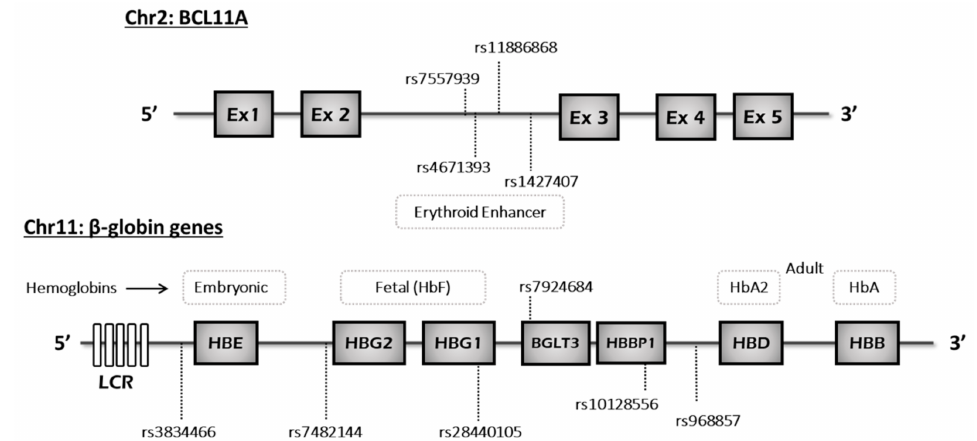
Figure 1. β -globin cluster and BCL11A gene representation. All the SNPs were identified through NGS analysis and four of these were used in haplotype